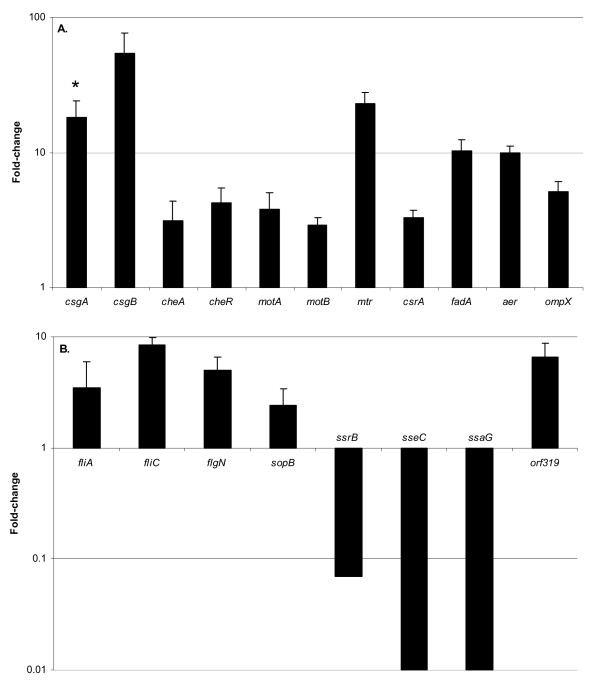
Biofilm-regulated S. Typhimurium gene expression. (A) A subset of genes up-regulated in the biofilm that encode cell surface structures, motility, global regulation, and oxygen diffusion. Representative examples of the functional categories (Figure 1) are shown. (B) Type III secretion genes. Transcriptomic data from the flowing biofilm system (72 h) was normalised to the planktonic samples and values are shown as fold change on a logarithmic scale (e.g. value of 10 on the Y-axis corresponds to 10-fold up-regulated). All genes were significant at P < 0.01 (* denotes that the csgA gene was significant at P < 0.05).